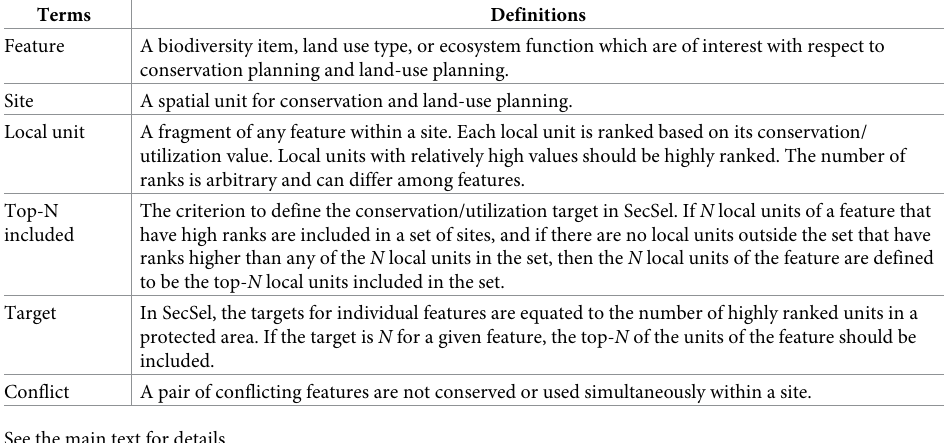
Table 1. Abbreviated explanations for the definitions of terms used in SecSel. A biodiversity item, land use type, or ecosystem function which are of interest with respect to conservation planning and land-use planning. A spatial unit for conservation and land-use planning. A fragment of any feature within a site. Each local unit is ranked based on its conservation/ utilization value. Local units with relatively high values should be highly ranked. The number of ranks is arbitrary and can differ among features. The criterion to define the conservation/utilization target in SecSel. If N local units of a feature that have high ranks are included in a set of sites, and if there are no local units outside the set that have ranks higher than any of the N local units in the set, then the N local units of the feature are defined to be the top- N local units included in the set. Target In SecSel, the targets for individual features are equated to the number of highly ranked units in a protected area. If the target is N for a given feature, the top- N of the units of the feature should be included. Conflict A pair of conflicting features are not conserved or used simultaneously within a site. See the main text for